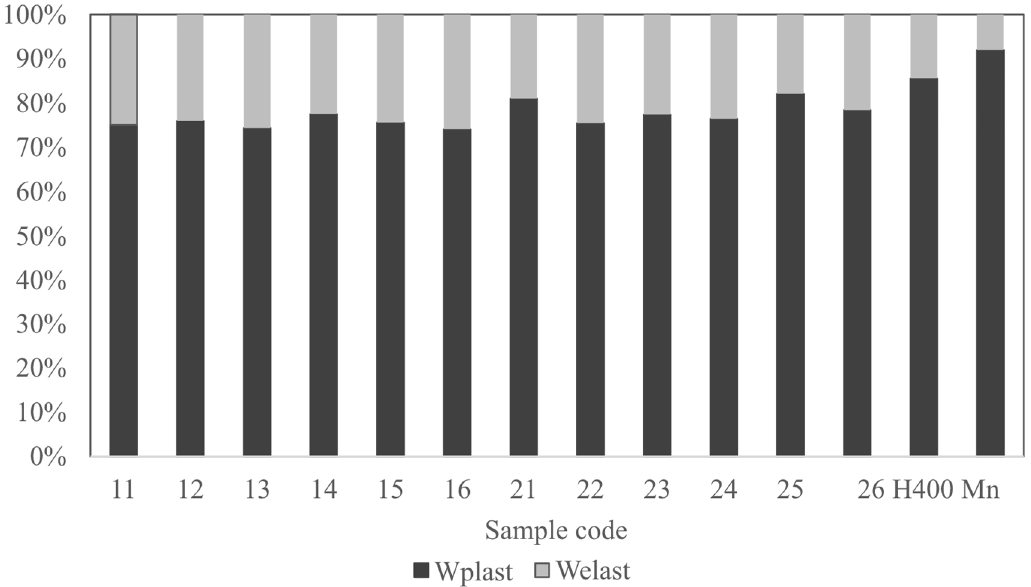
Figure 14. The ratio between plastic and elastic works performed during indentation (unloading) of materials by Vickers indenter with a load of 150 kg.